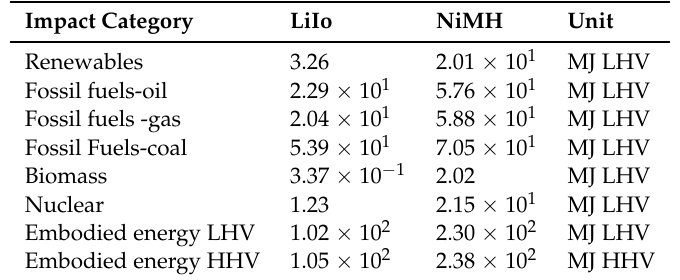
Figure 12. Comparative fuel-based energy consumption by LiIo and NiMH batteries, using the CED approach. Table 7. Comparison of fuel-based energy consumption by LiIo and NiMH